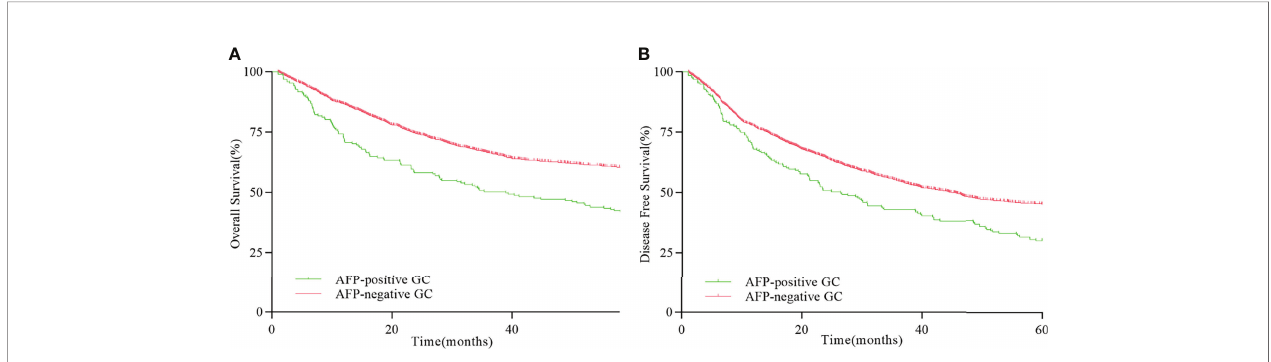
FIGURE 1 | (A) Comparison of OS rates between AFP-positive GC and AFP-negative GC ( P < 0.001). (B) Comparison of DFS rates between AFP-positive GC and AFP-negative GC ( P < 0.001).